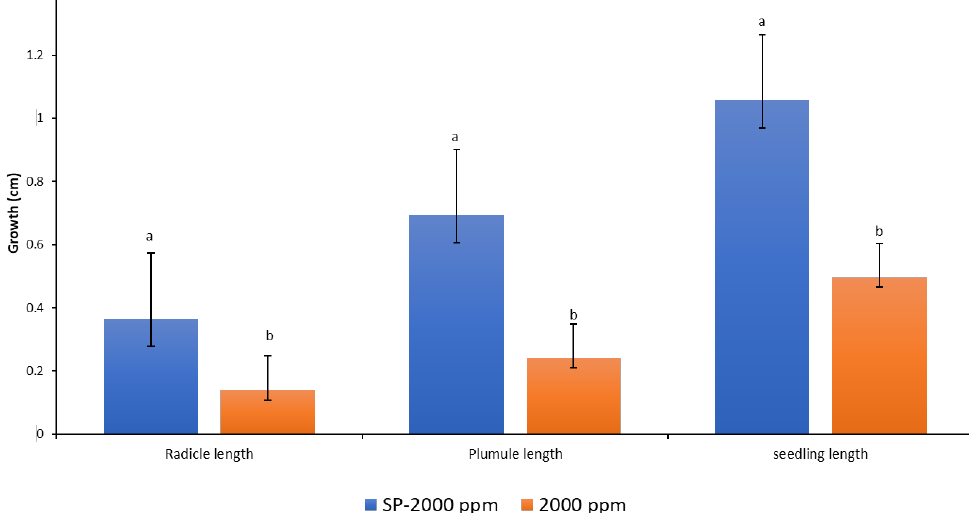
Figure 7. Response of the radicles, plumules, and seedlings to media amended with anti-fungicide (Amistar Xtra) and Hypo solution SP. Values denoted with different letters are significantly different at p < 0.05.